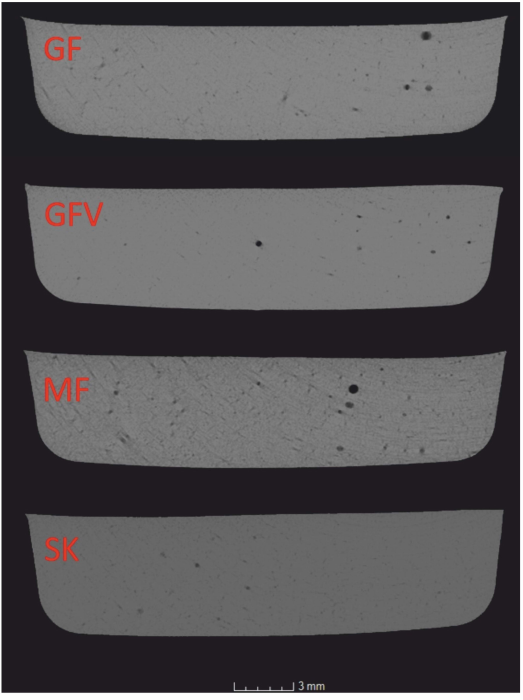
Figure 5. An example microtomographic scan of a chocolate